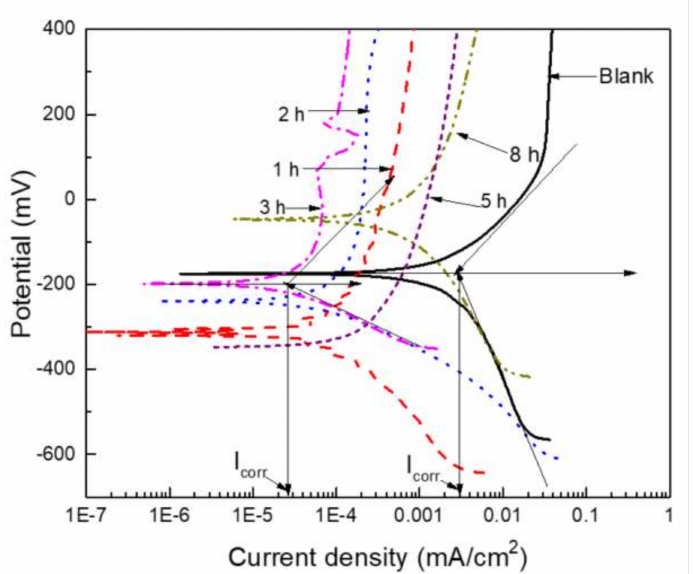
Figure 4. Effect of the oxidizing time on the polarization curves for Ti6Al4V alloy corroded in artificial saliva solution. In addition, schematic representation for the calculation of the I corr